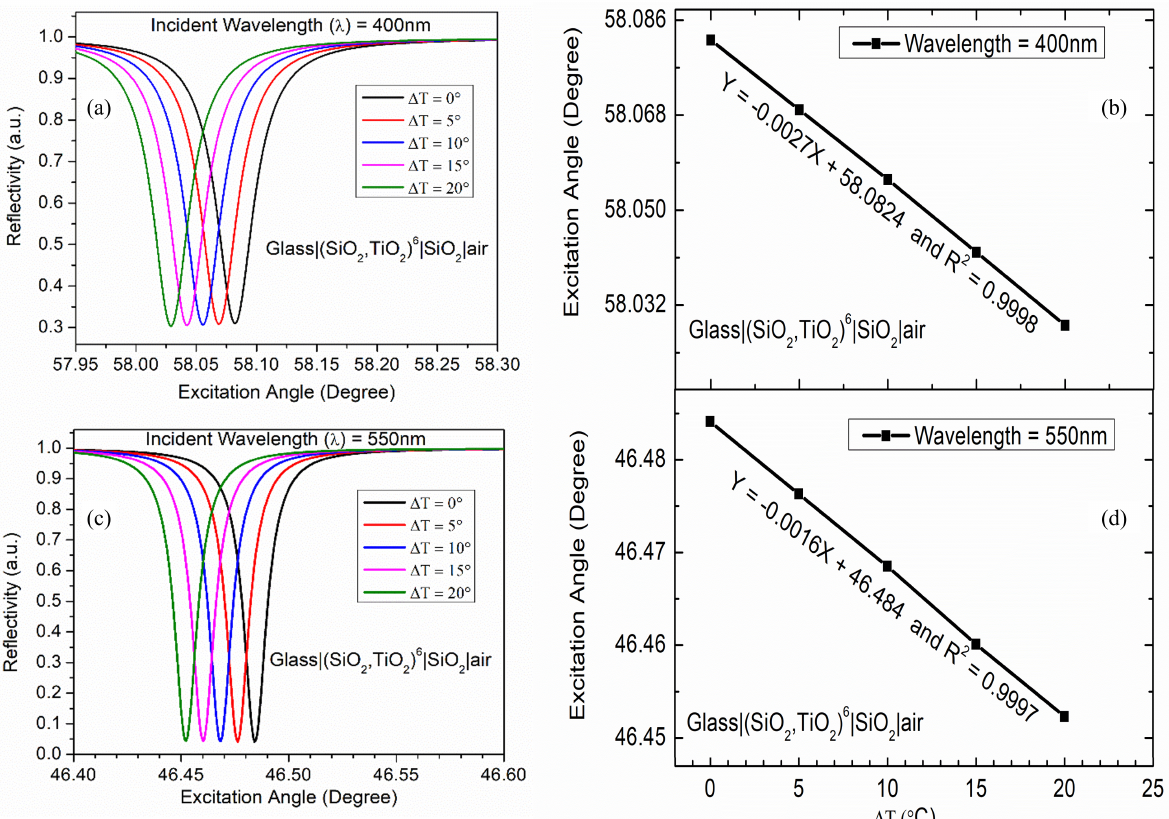
Figure 5. Effect of increasing device temperature on excitation angle for incident wavelength of, ( a ) 400 nm, ( b ) Corresponding linear profile, ( c ) 550 nm, and ( d ) Corresponding linear